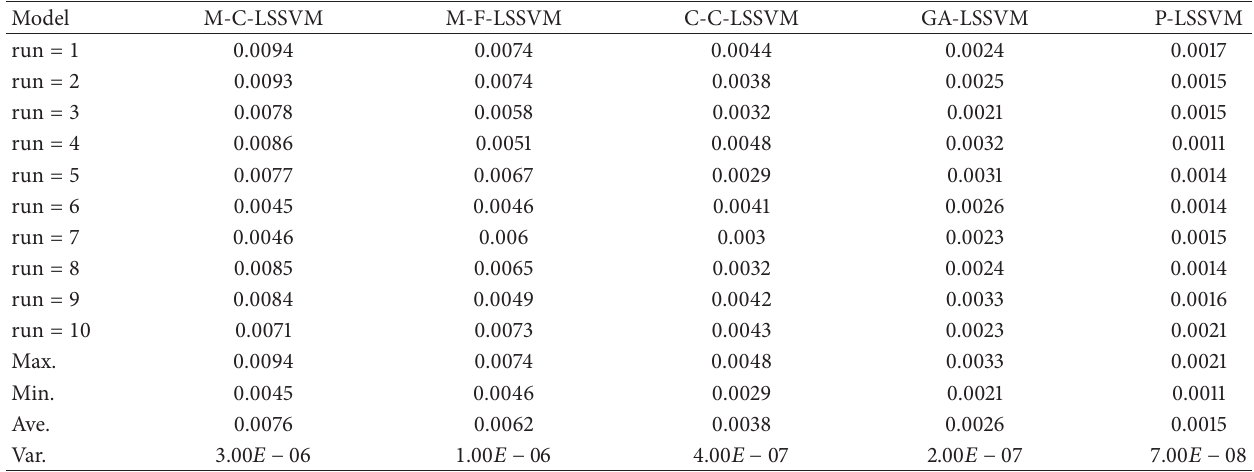
Table 8: Five models predicted error based on MASE for interphone